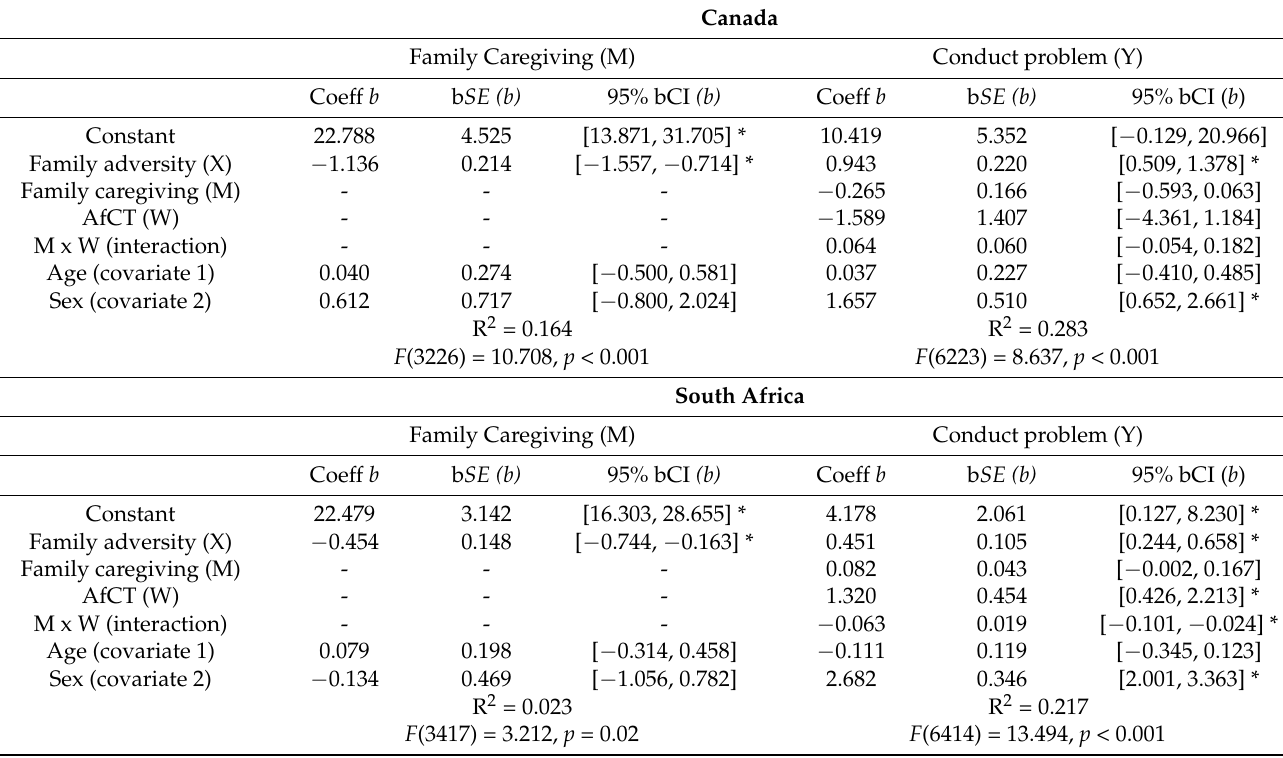
Table 4. Model coefficients for Model 2 in Figure